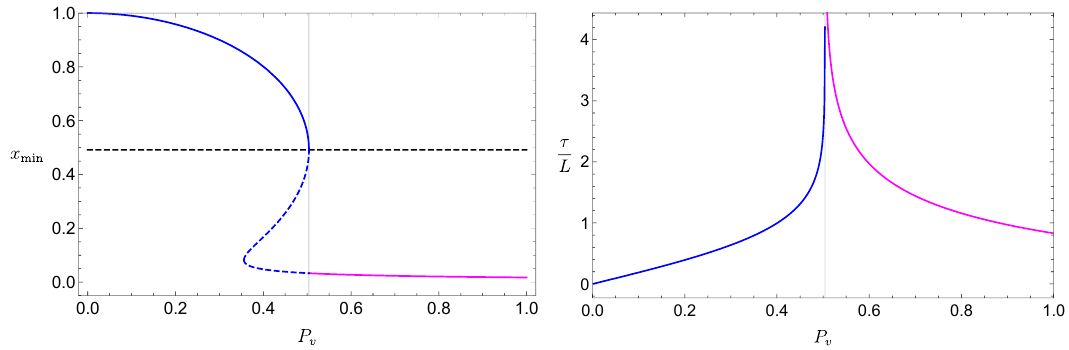
Figure 8 . Left: The minimal radius as a function of the conserved momentum P v . Here we choose the dimensionless parameter x . The solid blue curve and red curve correspond to the extremal min hypersurfaces with P and P , respectively. The middle dashed line presents the v ≤ P ∞ v ≥ P ∞ position of the final slice at r = r . Right: The relation between the boundary time τ and the f conserved momentum P . The middle transparent line indicates the critical momentum P v both plots, we choose ˜ λ = 1 , d = 3 500